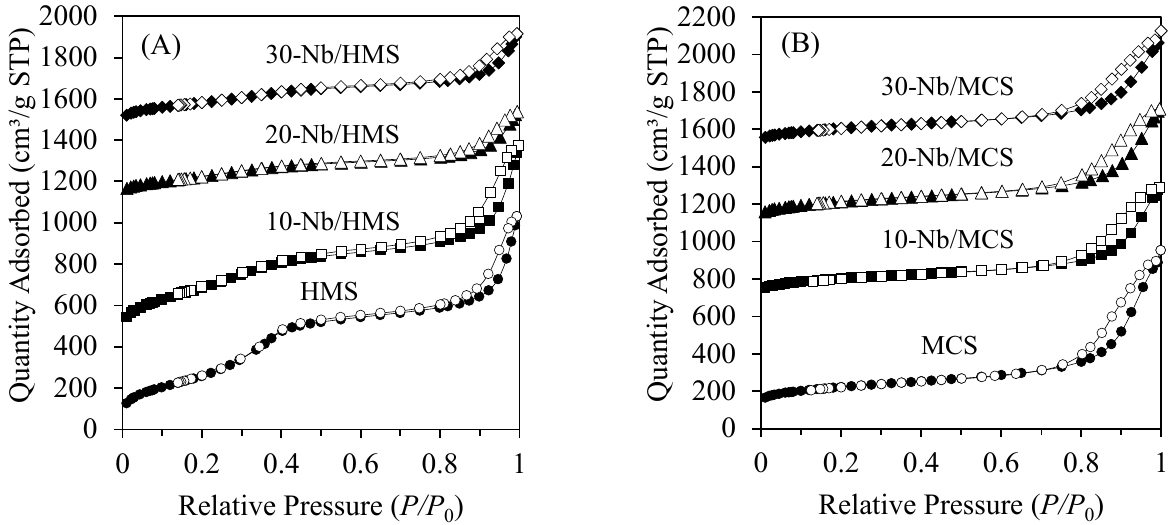
Figure 3. N 2 physisorption isotherms of ( A ) x -Nb/HMS and ( B ) x -Nb/MCS catalysts. Table 1. Physicochemical and acid properties of HMS and MCS with different Nb loading amount. Catalyst.